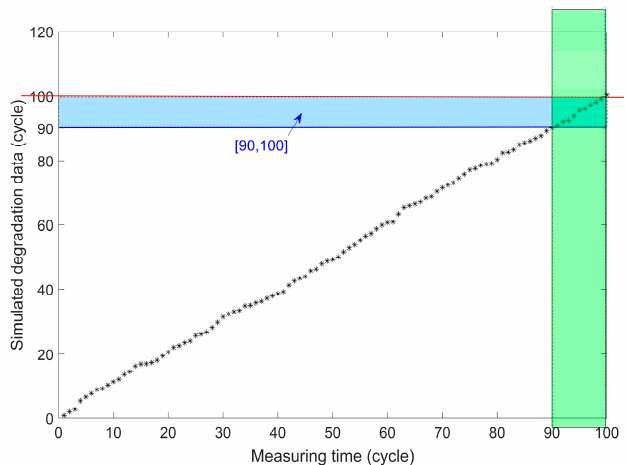
Figure 1. Degradation data from simulation.